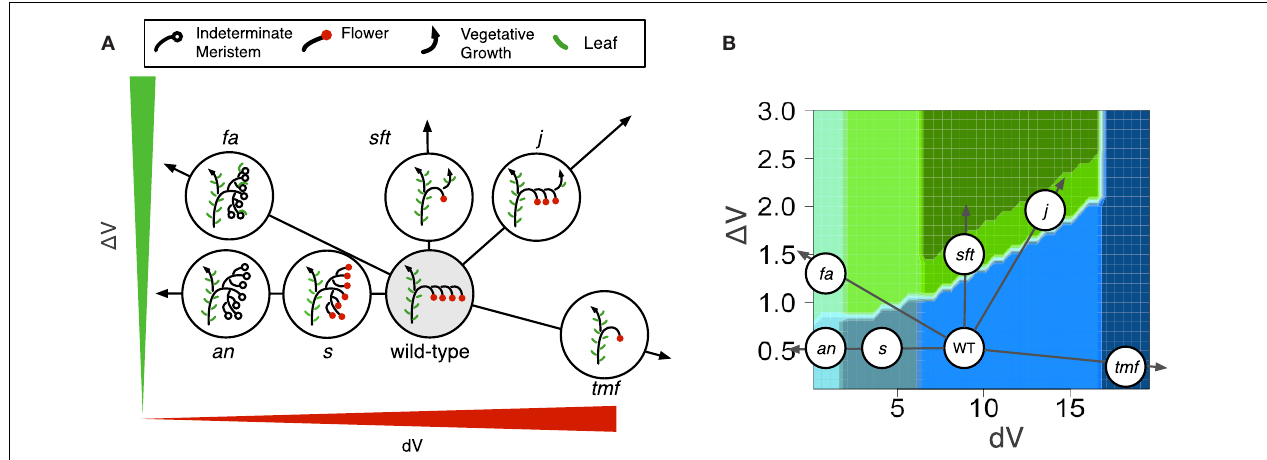
FIGURE 5 | Phenotypes of known tomato mutants (A) As explained by variations in dV and/or (cid:2) V and (B) placed in the morphospace of Figure 4.